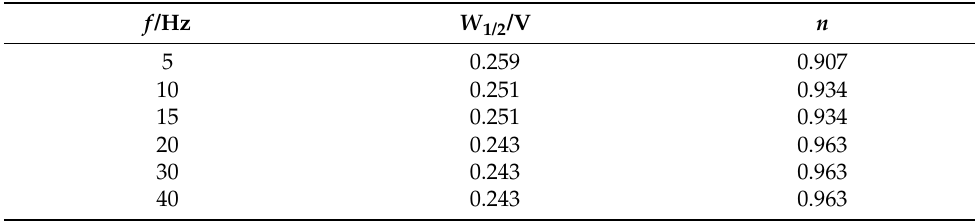
Figure 7. The binary phase diagram of the Pb-Yb system.